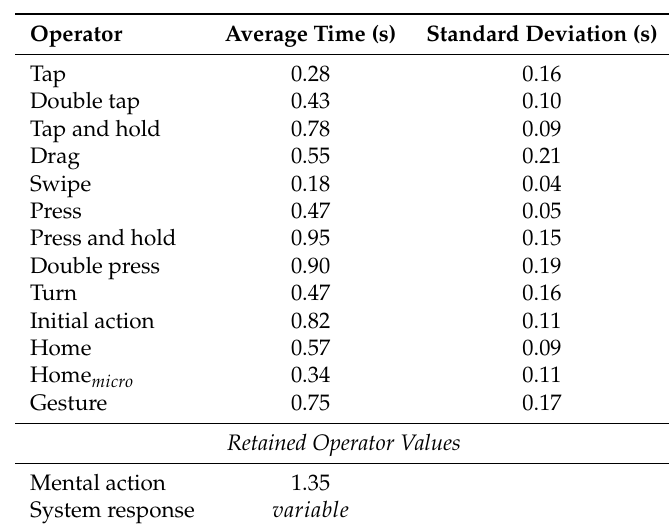
Table 5. Proposed average times and standard deviations for all operators identified in study 1, as reported in Section 4. The mental action and system response times are retained from the original KLM